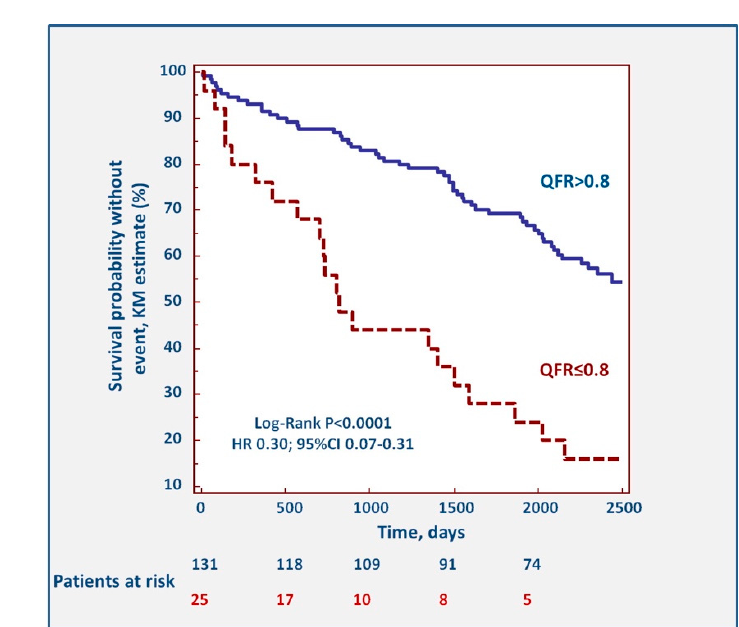
Figure 3. Kaplan–Meier survival curves of patients presenting with QFR >0.80 and ≤ 0.80. Table 4. Long-term MACCE predictors at multivariate analysis.